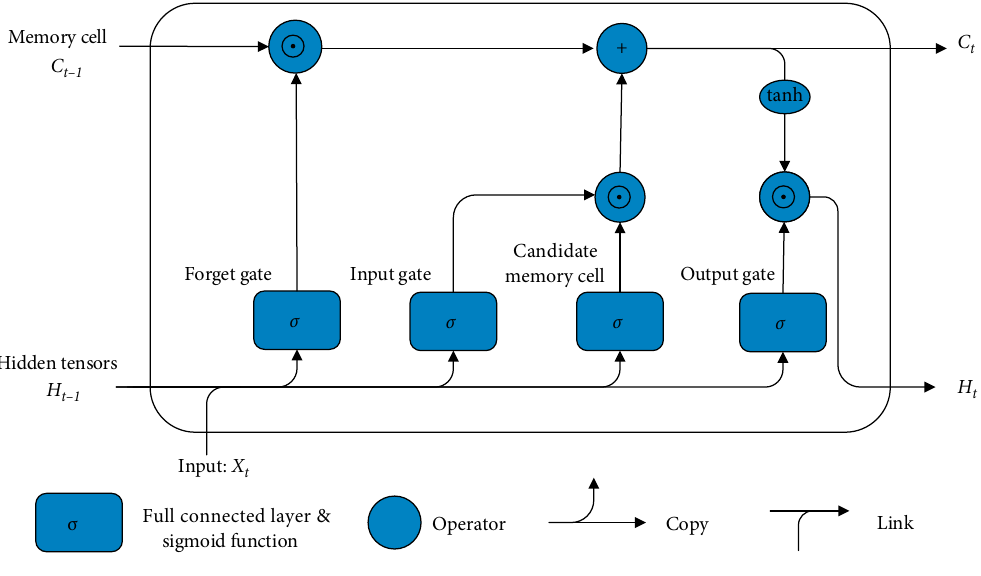
Figure 4: The inner structure of an LSTM